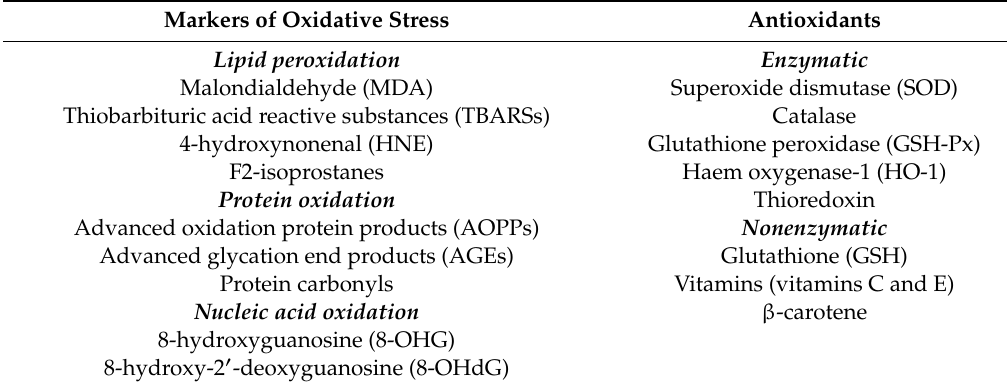
Table 1. Most important markers of oxidative stress and